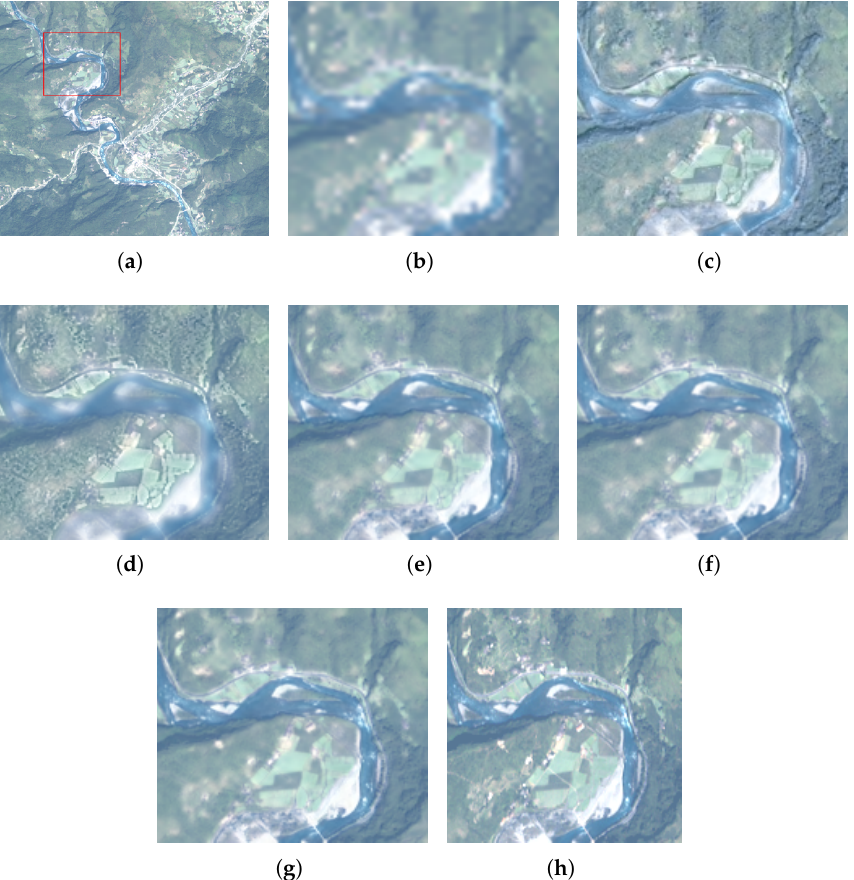
Figure 6. ( a ) Red rectangle area to be enlarged in the reference image. ( b – h ) are partial enlarged views of Figure